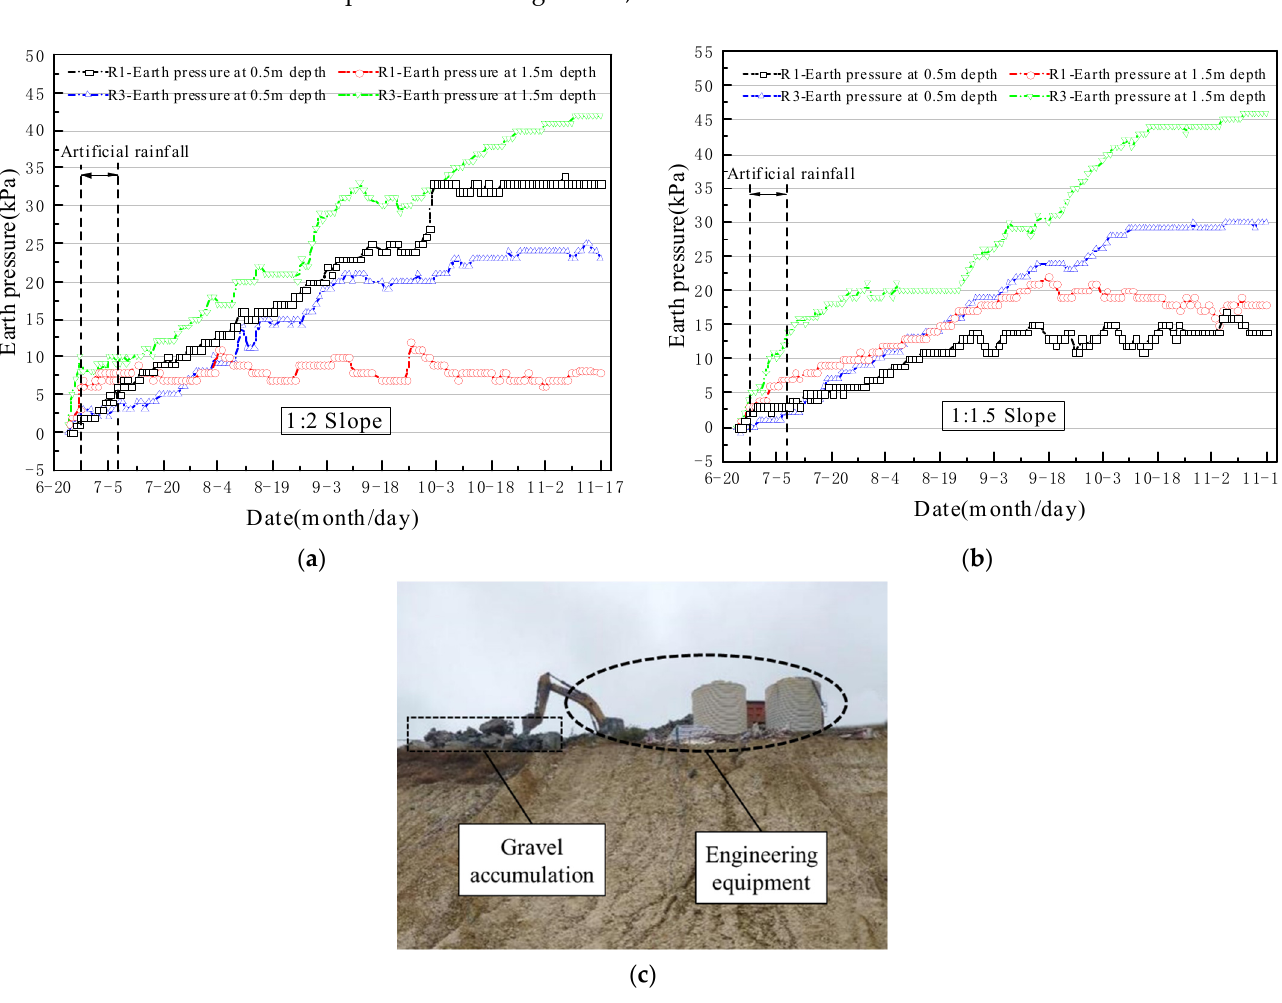
Figure 11. Lateral earth pressure analysis: ( a ) 1:2 natural slope lateral earth pressure variation trend; ( b ) 1:1.5 natural slope lateral earth pressure variation trend; ( c ) stacking on the top of the slope.